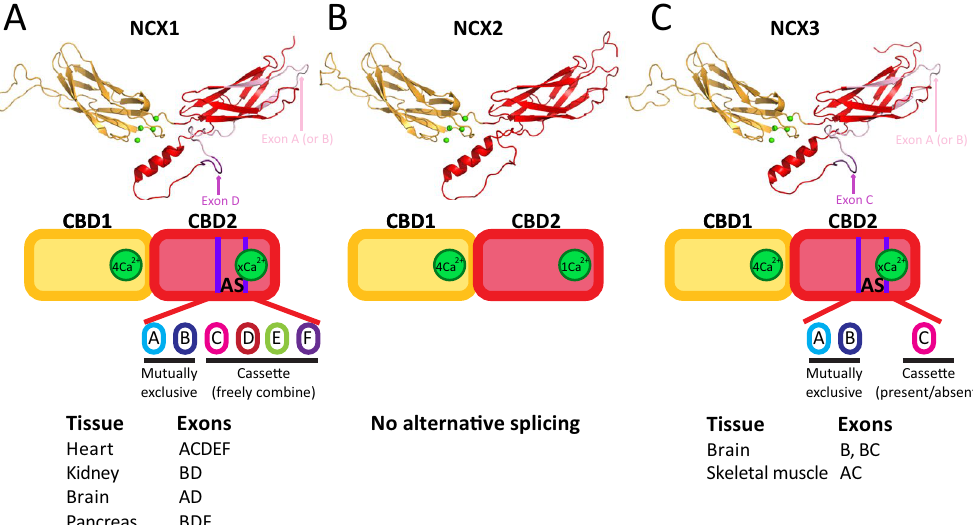
Figure 1. Structure and alternative splicing of NCX-CBD12 isoforms. The models of NCX1-CBD12-AD (brain splice variant) ( A ), NCX2-CBD12 ( B ), and NCX3-CBD12-AC ( C ) are presented as cartoons. CBD1 is in orange and CBD2 is in red. Four Ca 2 + ions bound to CBD1 are presented as green spheres. The alternative splicing schemes of NCX1 ( A ), NCX2 ( B ), and NCX3 ( C ) are presented below the